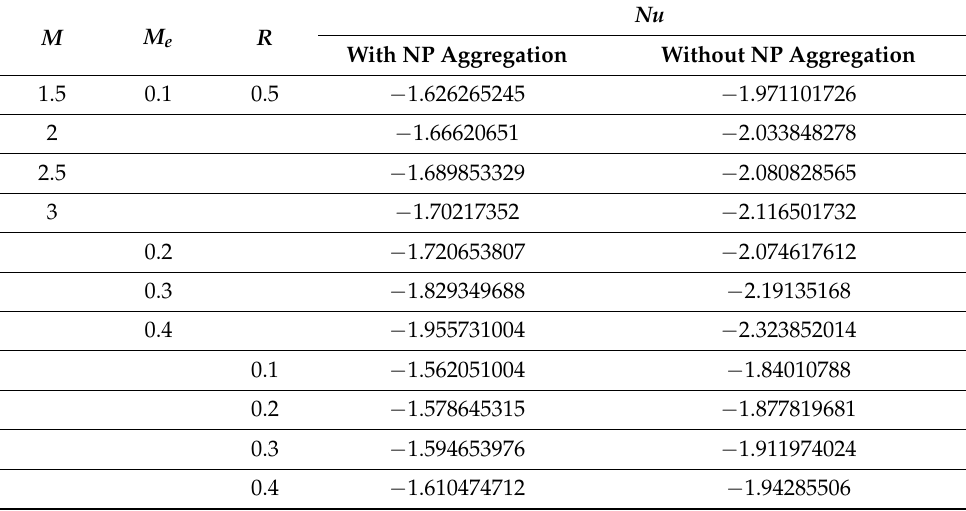
Table 4. Numerical values of the θ (cid:48) ( 0 ) for varied R , M e and M